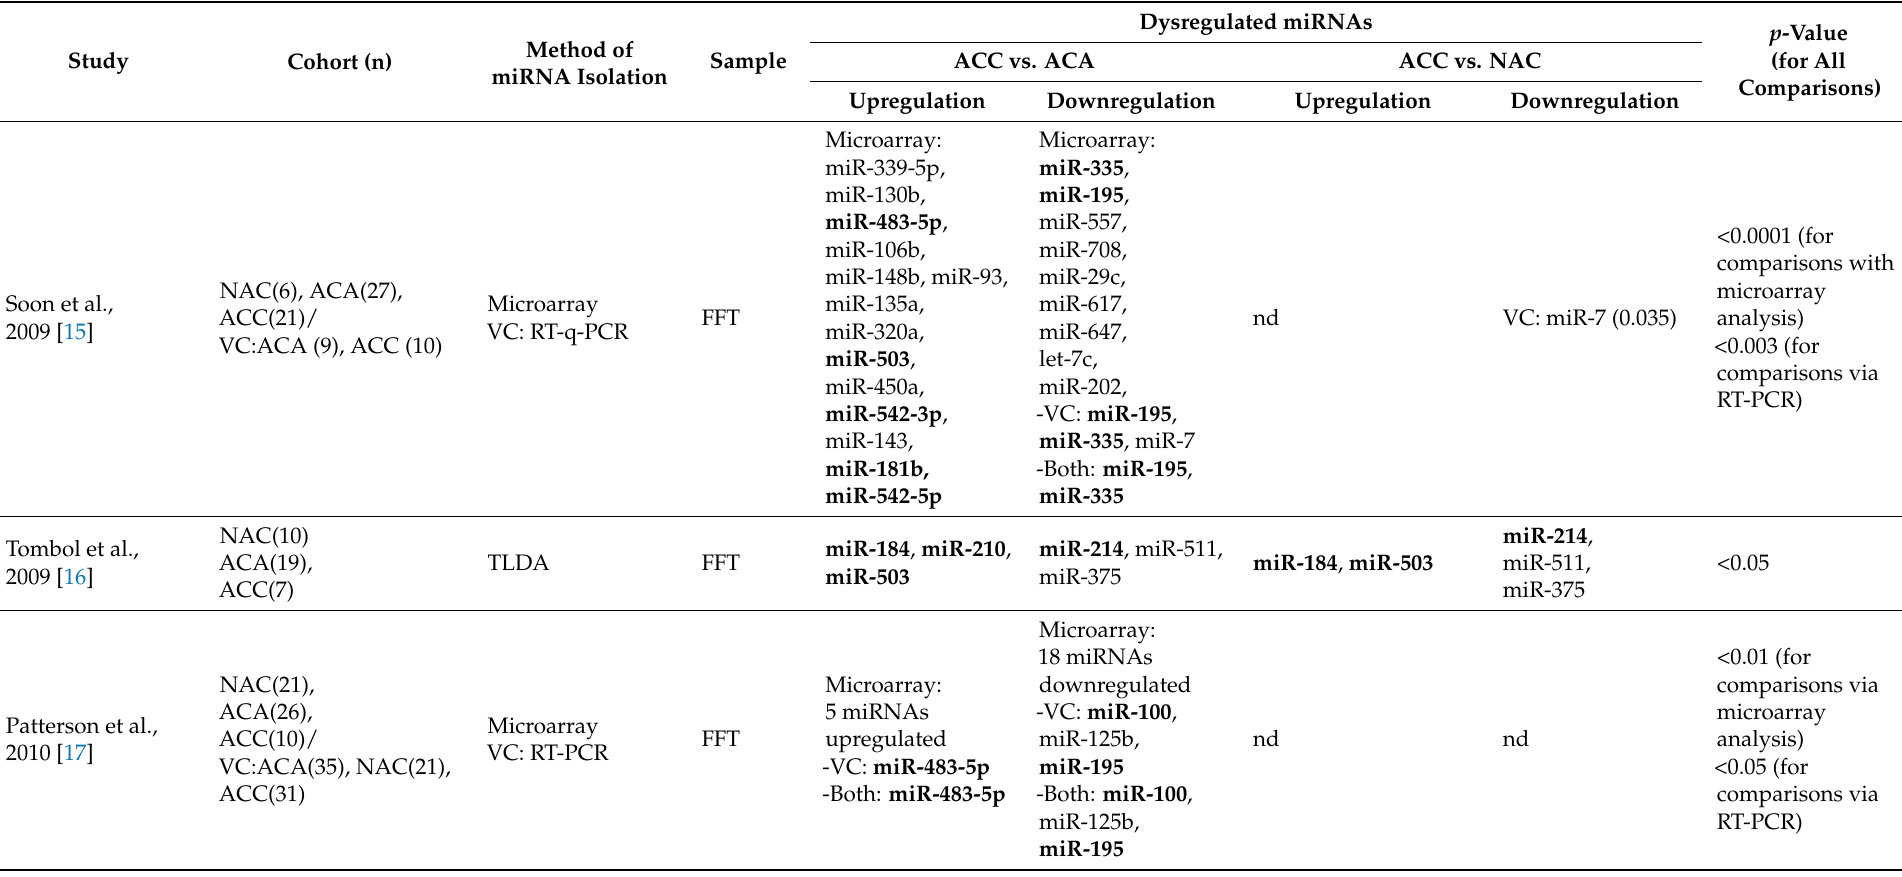
Table 1. Comparison of miRNAs’ expression in adrenocortical carcinomas (ACCs), adrenocortical adenomas (ACAs) and/or normal adrenal cortices (NACs).